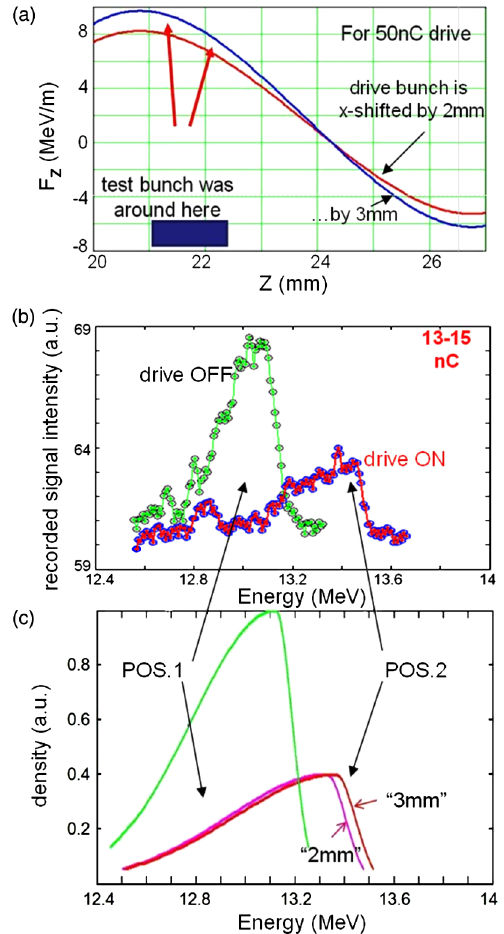
FIG. 13. (a) Simulations of F z for the test channel [values are renormalized to 50 nC (see explanations in the text)] for the delay 10.7 mm. (b) Typical energy distribution (observed in 80% of shots; normalized to 1). (c) CST MICROWAVE STUDIO simulations to predict changes in the energy distribution [for case #2 in Table V, and the drive bunch being shifted off the center of its respective channel by 2 mm (toward the test channel)].